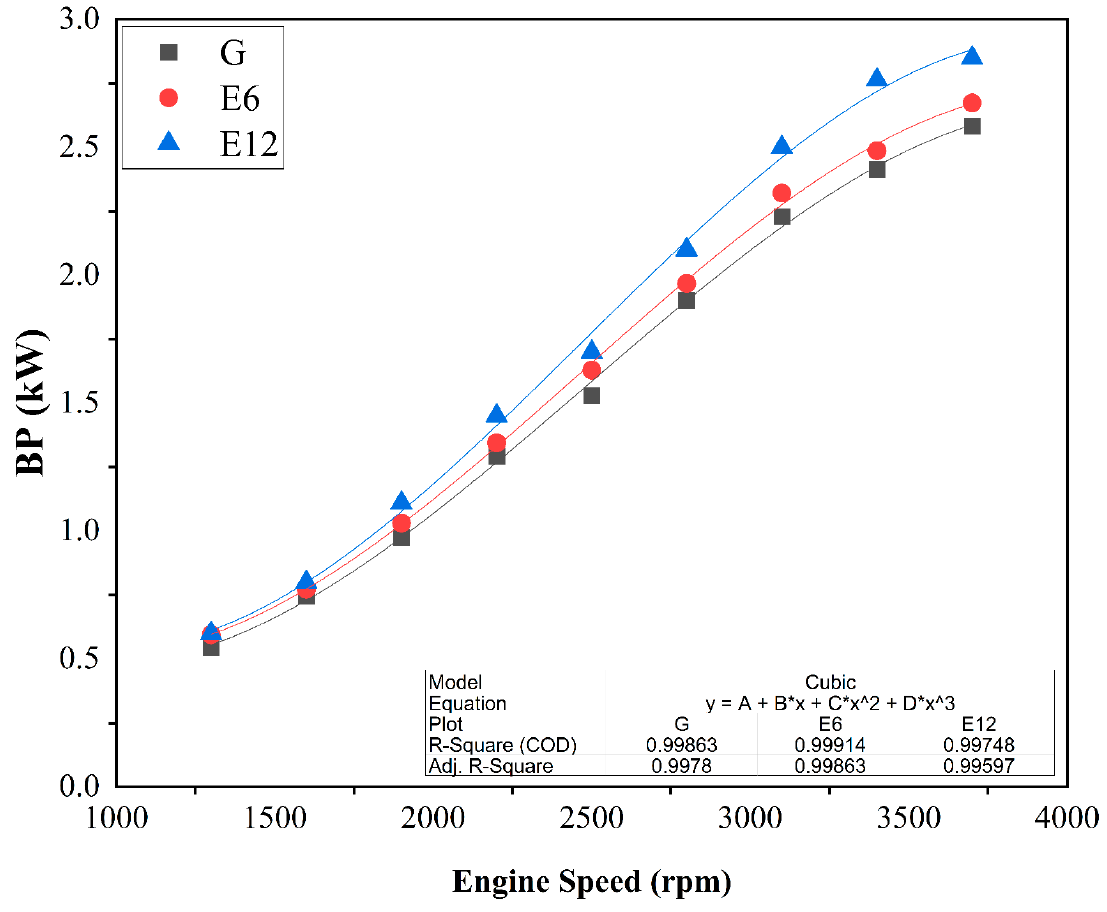
Figure 3. Brake power variation with engine speed.